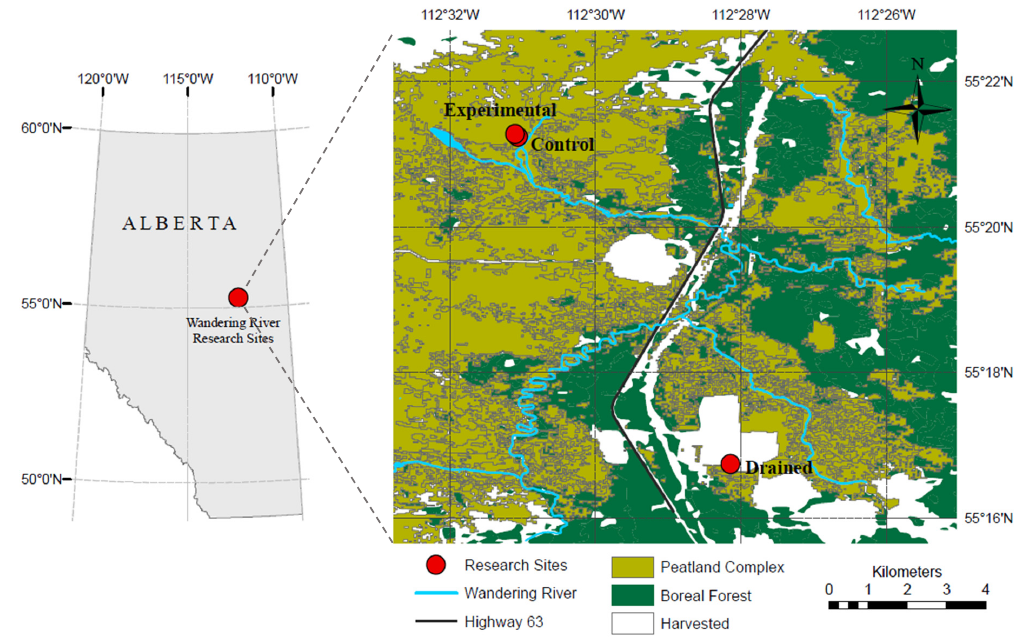
Figure 1. Geographical map of the Wandering River study sites located in a forested peatland complex within boreal forest in Alberta, Canada [54].